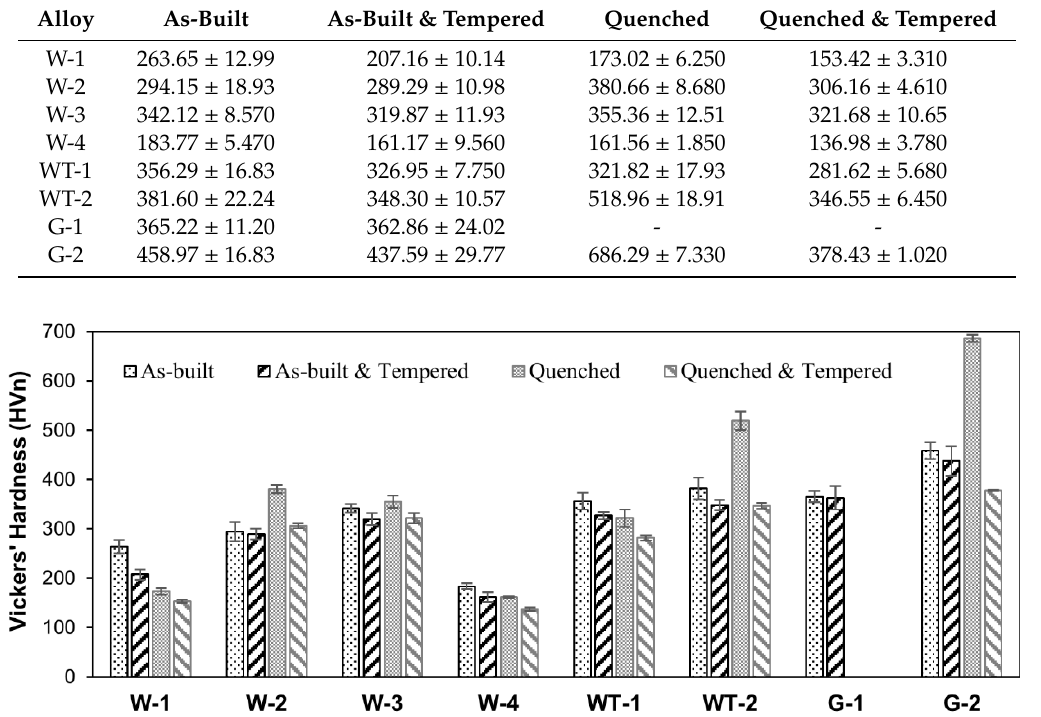
Figure 11. Vickers’ hardness of the L-PBF processed alloys as a function of thermal treatments. Table 5. Vickers’ microhardness of the investigated steels.